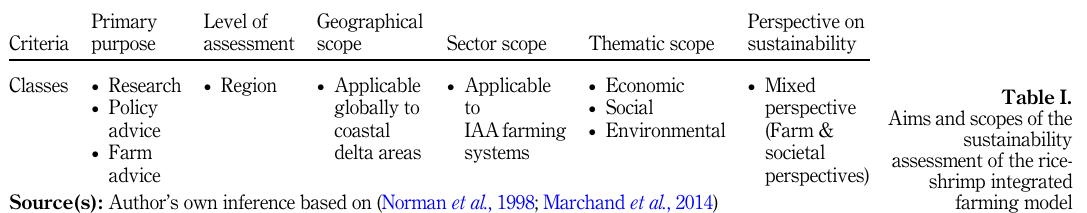
Table I. Aims and scopes of